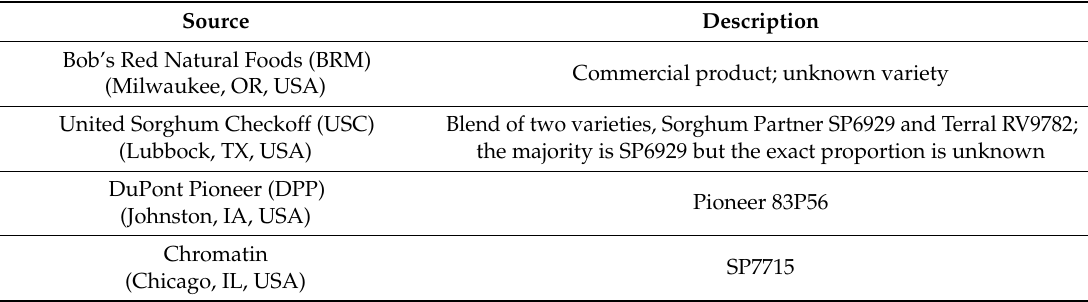
Table 1. Sources and descriptions of sorghum